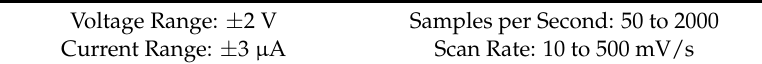
Table 10. Principal electric features of the EPS.